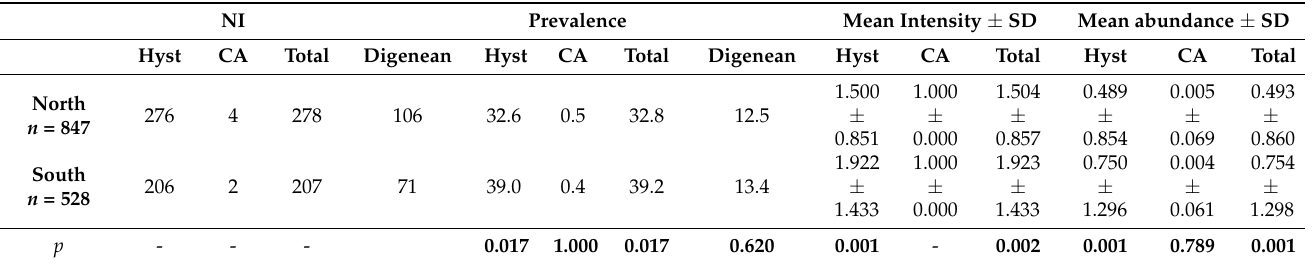
Table 2. Nematodes found in Sardina pilchardus individuals in two areas with different thermal regimes in the Catalan Coast, located in the Northwestern Mediterranean Sea, the more northerly Costa Brava and the more southerly Ebro Delta. Hyst, Hysterothylacium spp; CA, Contracaecum spp; Total, overall nematode parasites; Digenean trematodes.